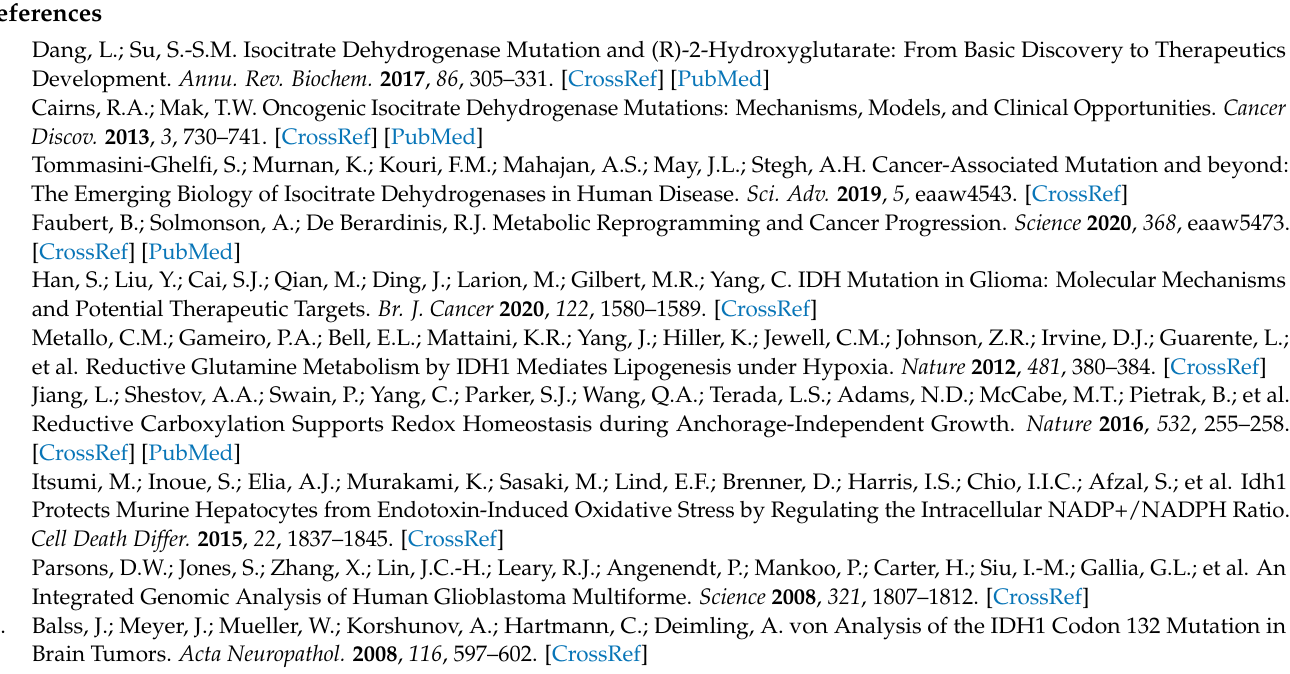
Table S2: Mutual exclusivity of IDH2 and TP53 alterations in human cancer, Table S3: Low co- occurrence frequencies of specific IDH2 mutation and TP53 alteration in human cancer, Table S4: Gliomas are the predominant cancer type harboring co-occurrence of specific IDH1 mutation and TP53 alteration in TCGA_PanCancer, Table S5: Gliomas of various histological types constitute the predominant cancer type harboring co-occurrence of specific IDH1 mutation and TP53 alteration in MSK_Impact, Table S6: Gliomas of different studies collectively constitute the predominant cancer type harboring co-occurrence of specific IDH1 mutation and TP53 alteration in Non-Redundant, Table S7: Multivariate Cox proportional hazards analysis of TP53 status in TCGA-LGG dataset, Table S8: Multivariate Cox proportional hazards analysis of TP53 status in the IDH1 -wildtype subgroup of TCGA-LGG dataset, Figure S1: Distinctive distribution of IDH1 , IDH2 , and TP53 alterations in Non-Redundant, Figure S2: Rare co-occurrence of IDH2 hotspot mutation and TP53 alteration in human cancer, Figure S3: Higher frequencies of co-occurrence of specific IDH1 mutation and TP53 alteration in glioma, Figure S4: IDH1 status and TP53 status distinguish patient survival in lower-grade glioma of